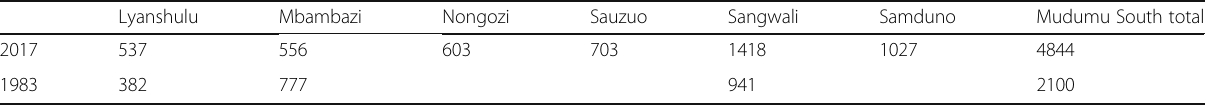
Table 1 Increase in cattle numbers in Mudumu South from 1983 to